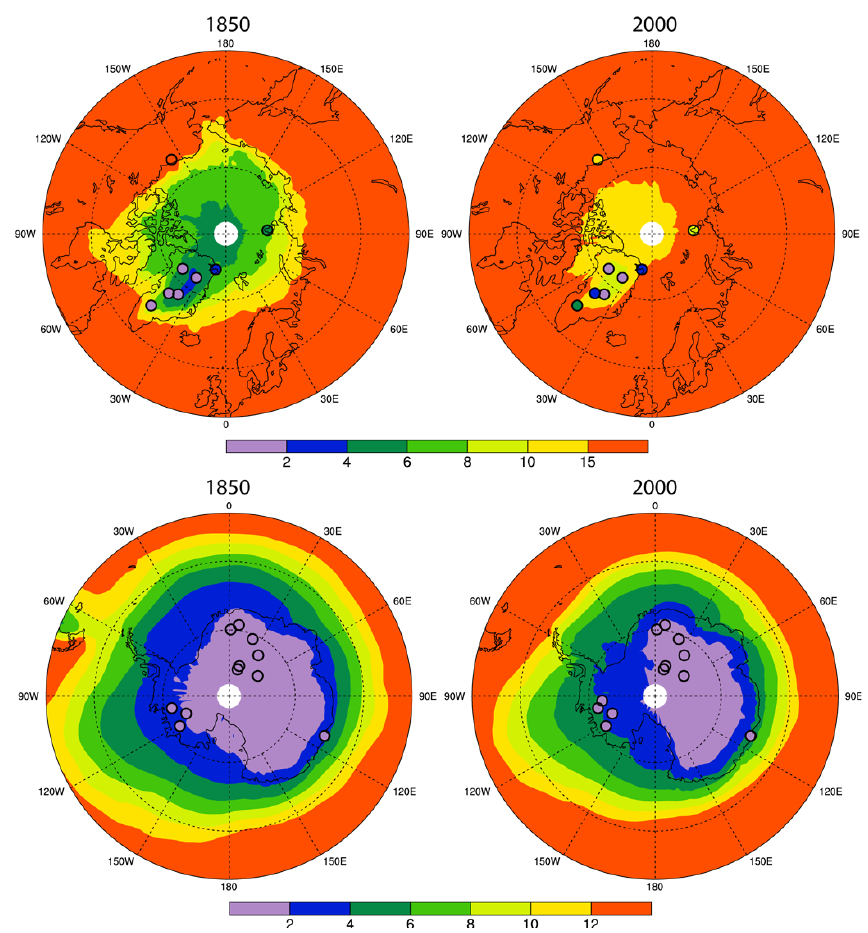
Fig. 4b. Ammonium deposition from ice cores (mg(N)m − 2 yr − 1 , filled circles, see Table S5) and MMM for 1850 (left column) and 2000 (right column). Top panel is for the Arctic region; bottom panel is for the Antarctic region. Contours are the MMM results; filled circles are the observations. Note different color scales between top and bottom